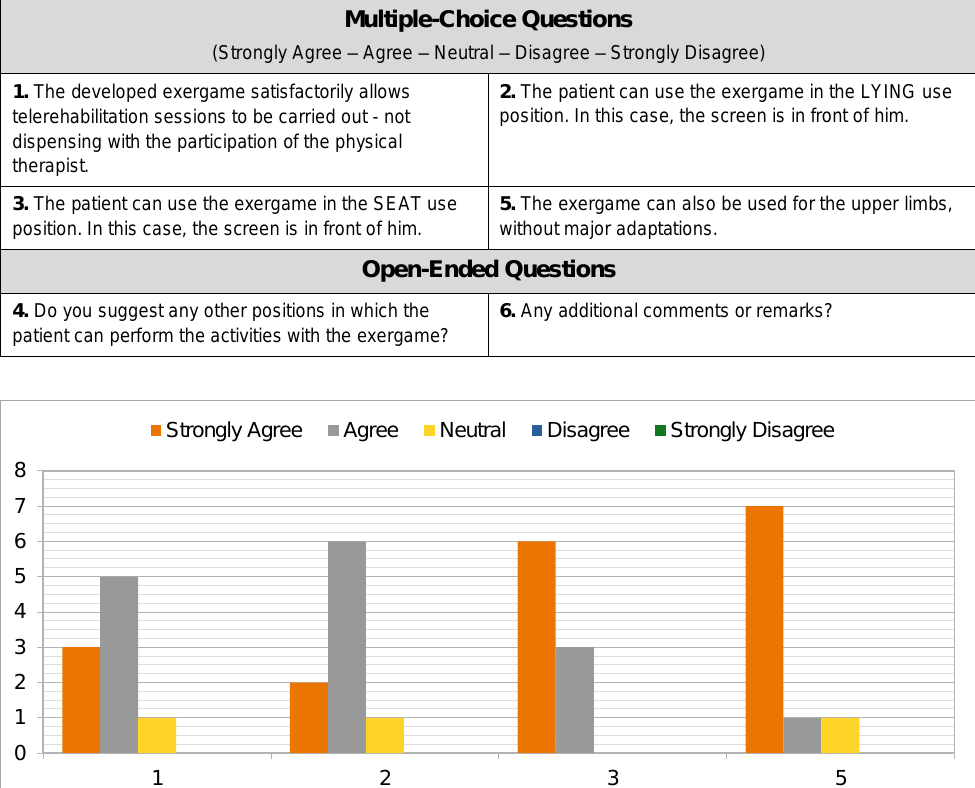
Table 3. Questions created for the second round.